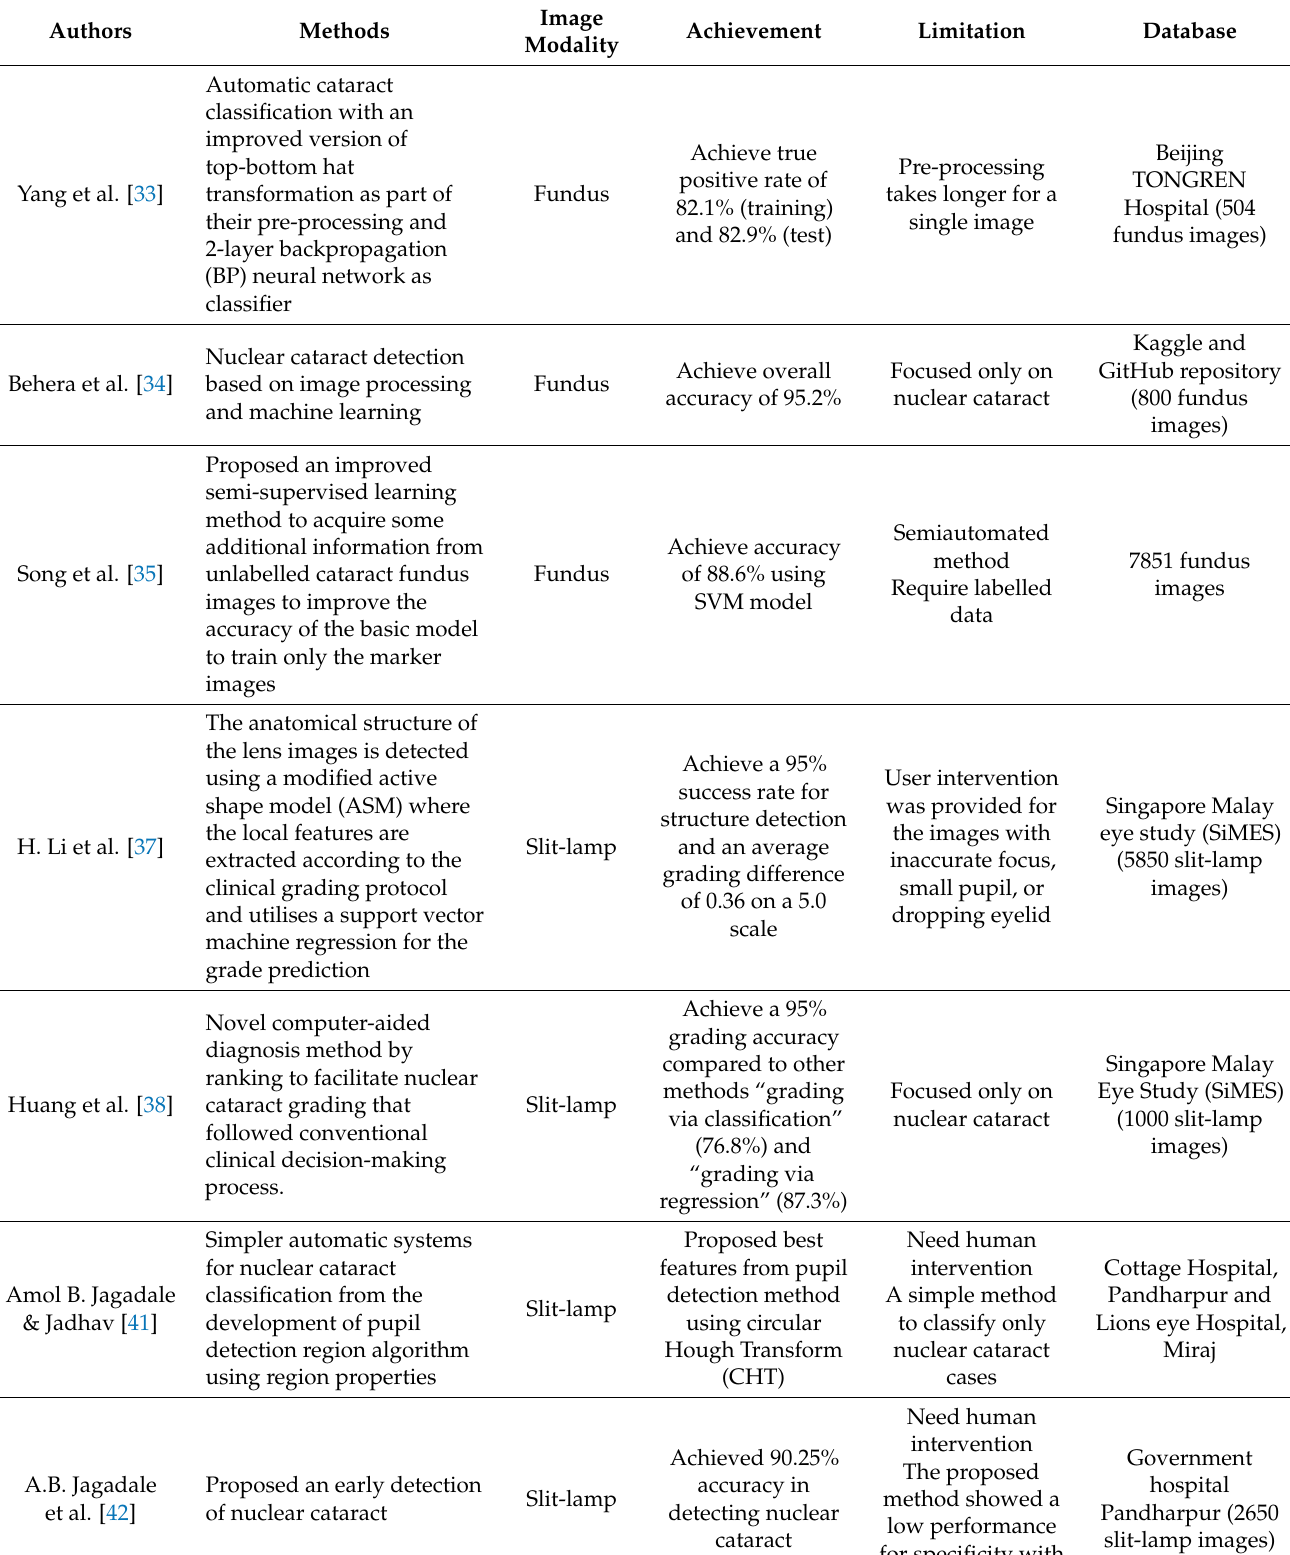
Table 1. Summary of Previous Methods Using Machine Learning and Image